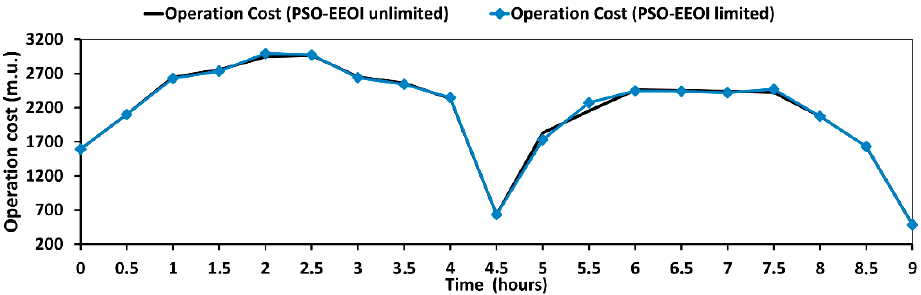
Figure 14. Ship power system operation cost (m.u.): PSO with/without EEOI limitation.